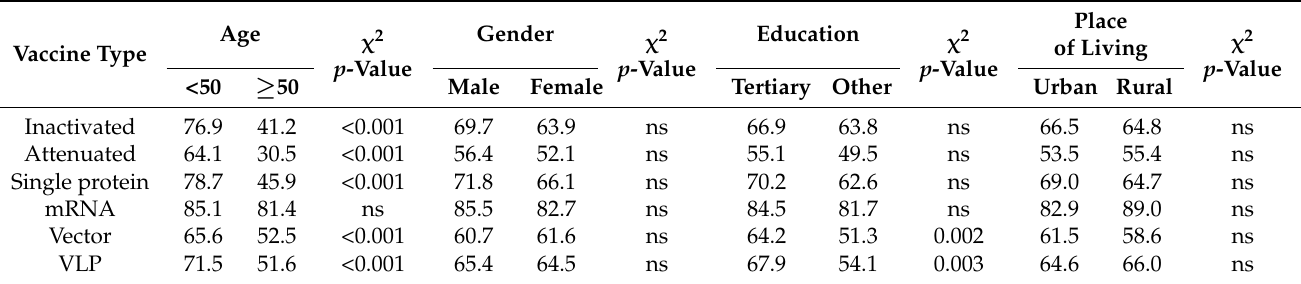
Table 3. The percentage of individuals in the studied group ( n = 1020) with the level of trust of >5 (in 1–10 Likert-like scale) in particular vaccine type in relation to age, gender, education and place of living.